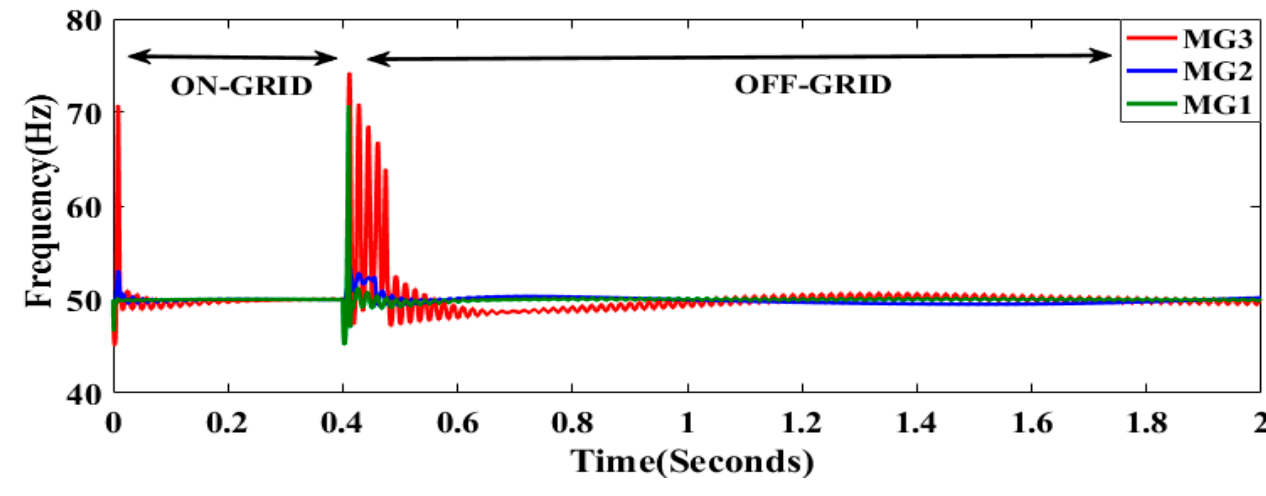
Figure 22. Frequency profile of the complex MG assembly during off-nominal situations with switching interruption and additional noise.